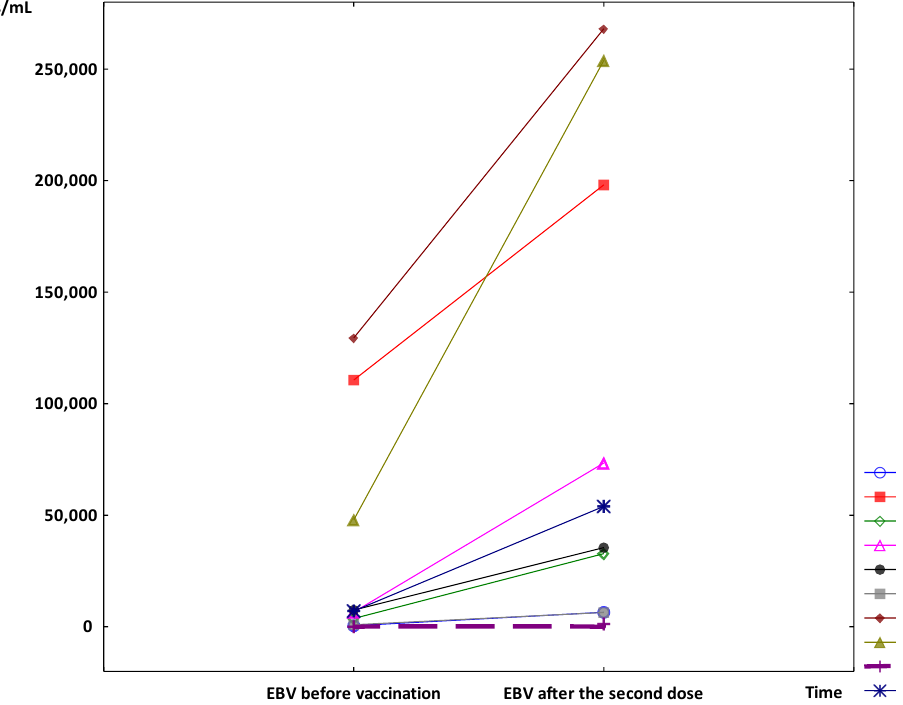
Figure 2. The individual results of the Epstein–Barr virus (EBV) viremia during the follow-up period (The individual symbols mark the next patients and the dashed line marks the results of the patient who reactivated EBV